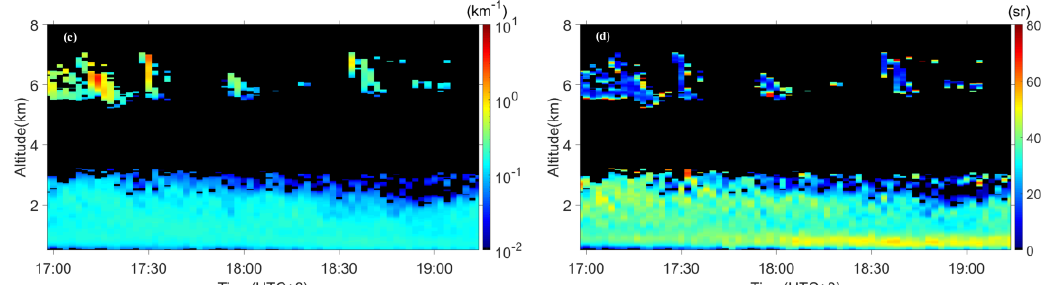
Fig 3 The data retrieval result during the measurement on March 12, 2019 at the Yuquan Campus of Zhejiang University. These four pictures are: (a) the depolarization ratio; (b) the backscatter coefficients; (c) the extinction coefficients; (d) the extinction-to-backscatter